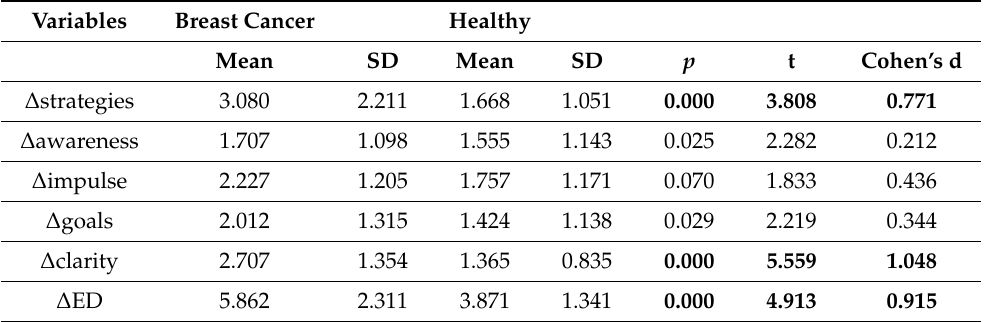
Table 9. Di ff erences between groups: independent samples t -test and Cohen’s d coe ffi cient. Gr.1: breast cancer patients, n = 50; Gr.2: healthy persons, n = 53. Variables Breast